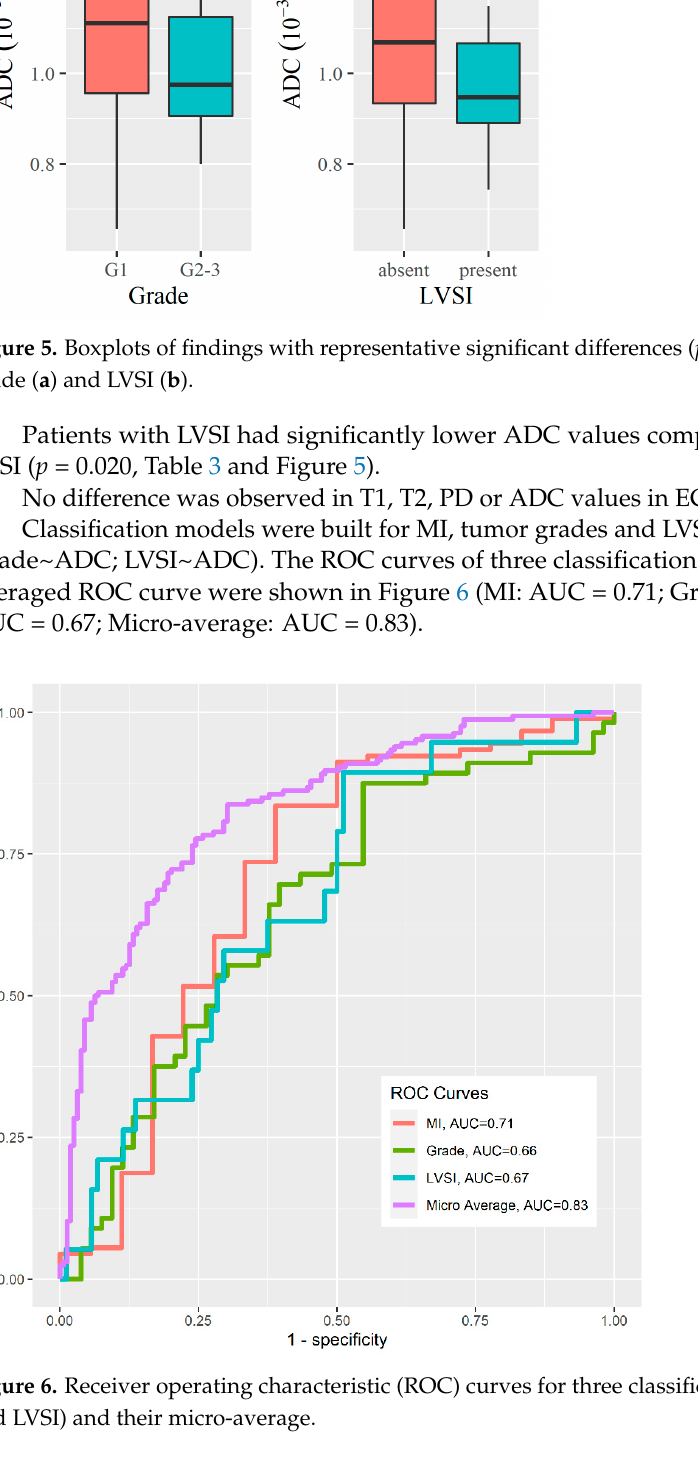
Figure 4. Boxplots of findings with representative significant differences ( p < 0.05) of T2 ( a ), PD ( b ) and ADC ( c ) in patients with or without MI. Patients with a G2–3 tumor had significantly lower ADC values compared to those with a G1 tumor ( p = 0.005, Table 3 and Figure 5). There was no difference in T1, T2 or PD values between G1 and G2–3 tumors.